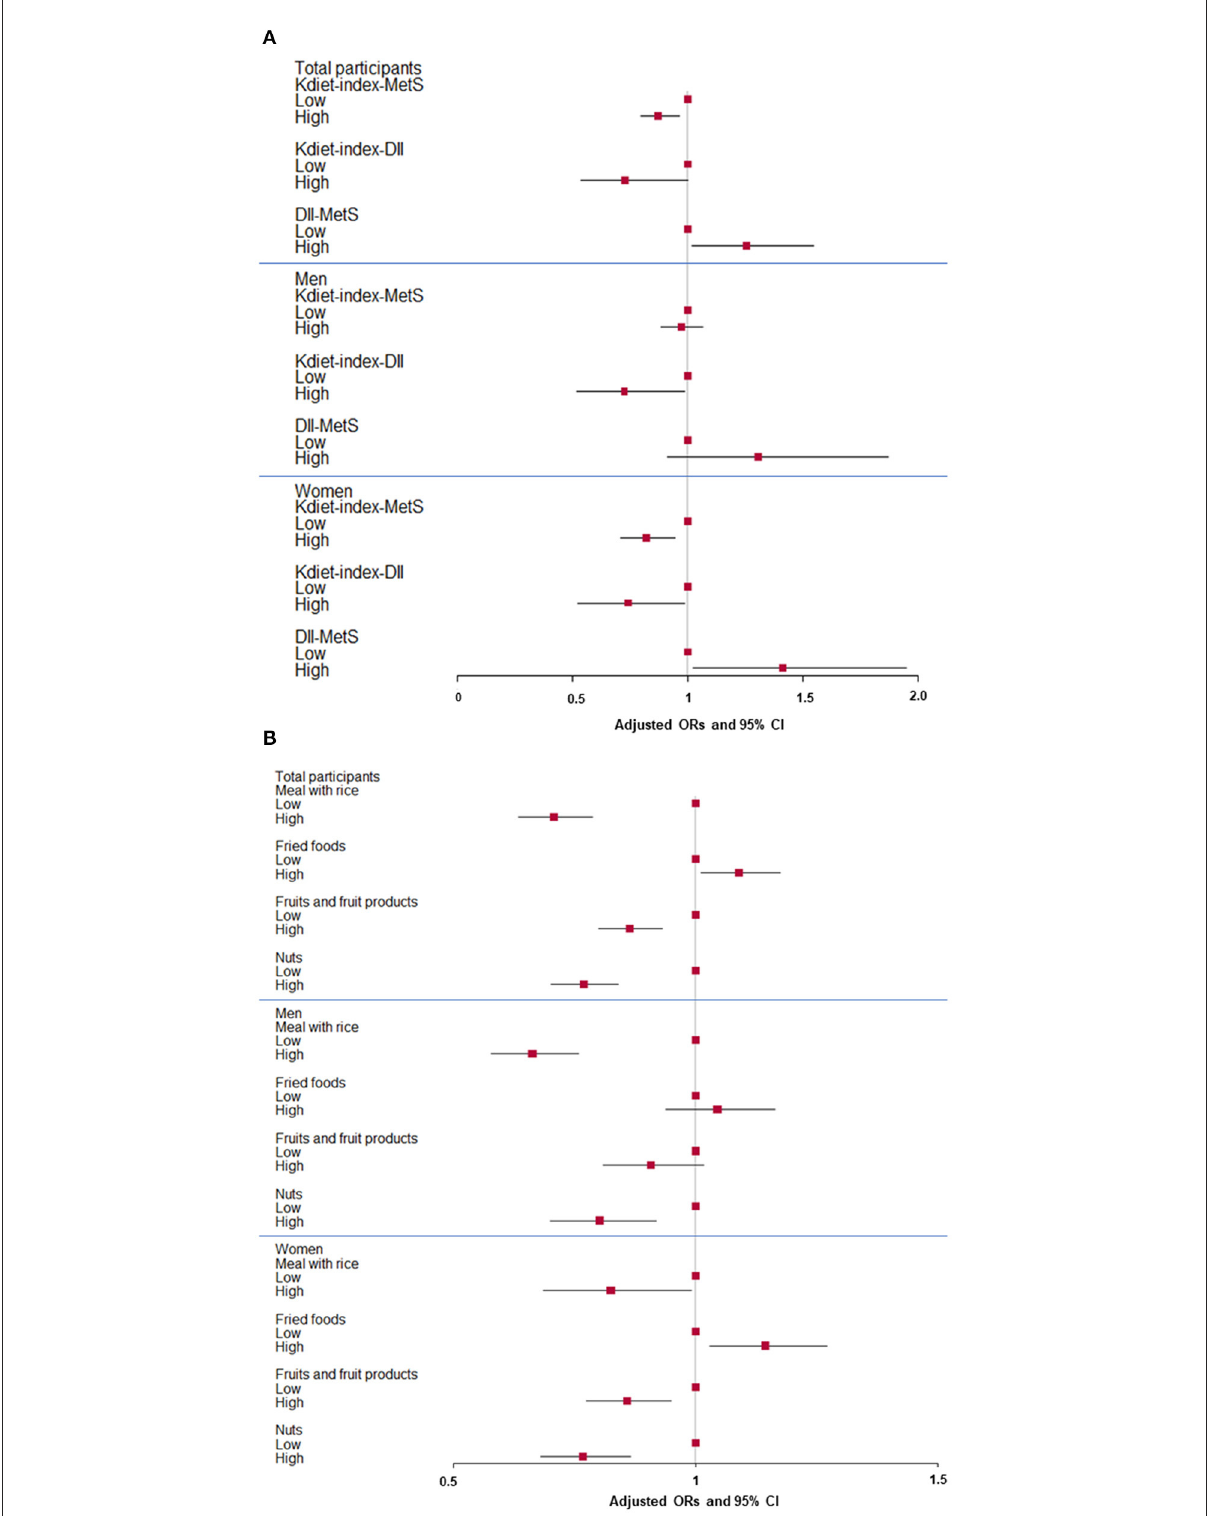
FIGURE1 Adjusted odds ratio (ORs) and 95% confidence intervals (CI) of hansik intake evaluated with K diet -index score and metabolic syndrome risk (MetS). (A) Association of K diet -index score with MetS and dietary inflammatory index (DII) and association of MetS and DII in men and women. (B) Association of some components of K diet -index with MetS in men and women. Hansik was defined with 14 components with portion sizes and scores. The cutoffs of a meal with multigrain rice, fried food intake, fruits, and fruit products, and nut intake were ≥ twice per day, < 3 times per week, ≥ 2 servings per day, and ≥ once a day, respectively. Red squares and lines indicated adjusted ORs and 95% CI, respectively. They were shown in total participants, men, and